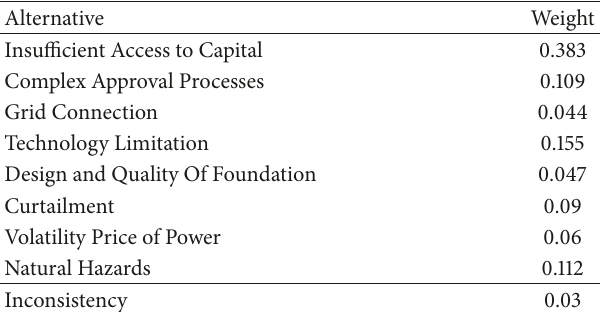
Table 4: Final weights of